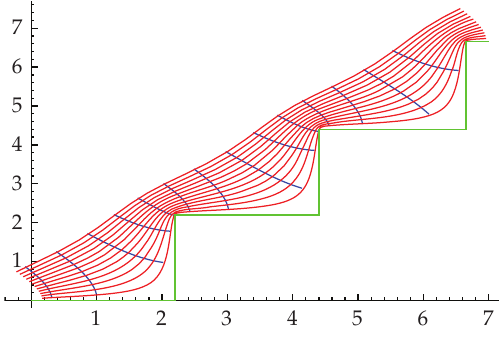
Figure 1: The infinite staircase. f (cid:5) z (cid:6) (cid:4)